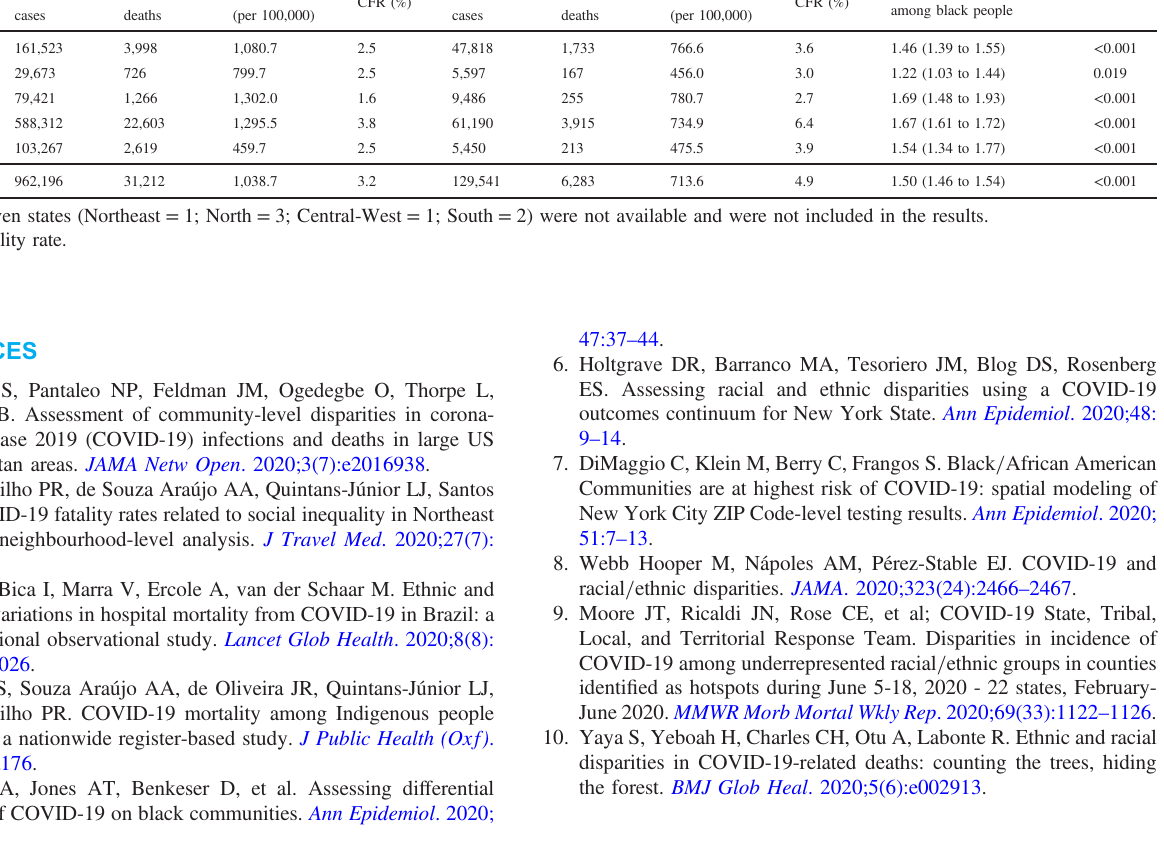
Table 1. Incidence rate, case-fatality rate, and relative risk for COVID-19 mortality among black people in Brazil according to macro- regions Region